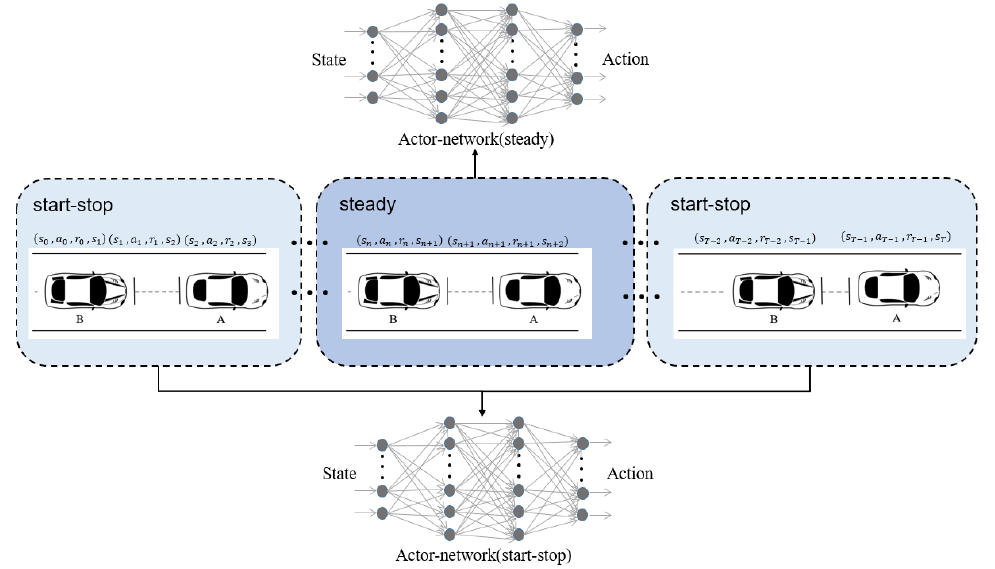
Figure 2. Actor-network at different